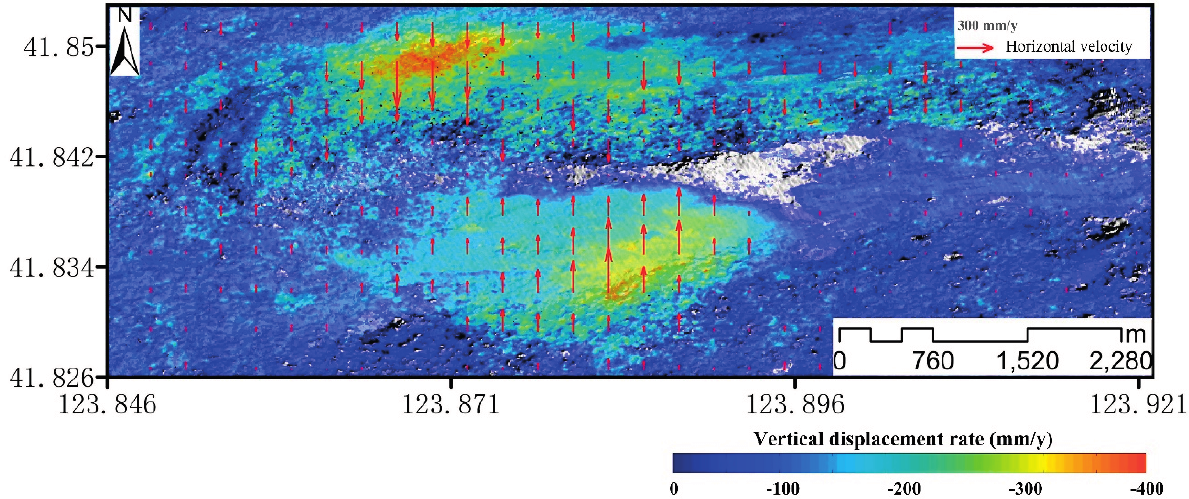
Figure 9. Integrated displacement velocity field of FWOPM landslide for the period of January 2007–January 2011. The background is a shaded relief map of SRTM DEM. The color represents the vertical displacement rate for the studied period. The red arrows represent the horizontal displacement velocity with different directions in the north and south parts of